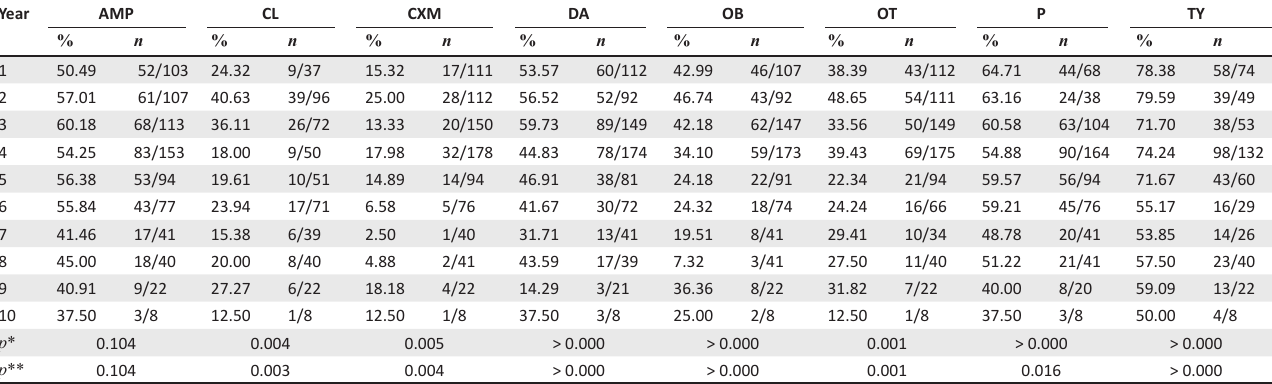
TABLE 2: Data of combined resistance ( % ) of the Staphylococcus aureus isolates with 5 or more years of sampling pooled for an indication of on-farm resistance out of the total of herds sampled. Year AMP CL